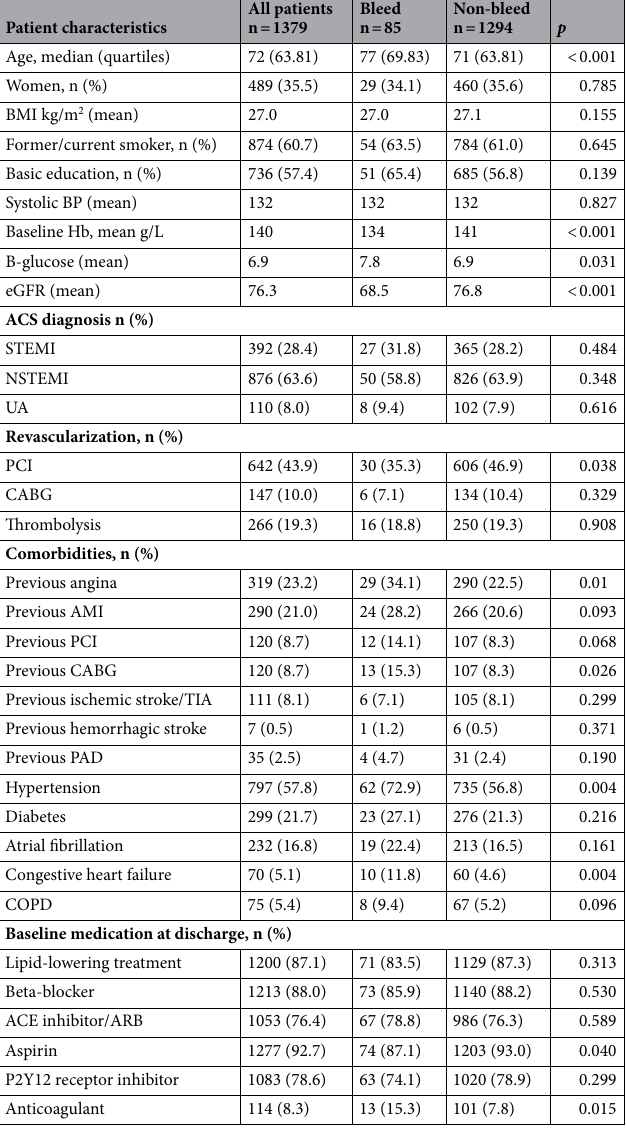
Table 1. Baseline characteristics stratified by bleeding. n number of patients, BMI body mass index, systolic BP blood pressure at discharge, eGFR estimated glomerular filtration rate calculated using mL/min/1.73 m 2 , ACS acute coronary syndrome, STEMI ST-elevation myocardial infarction, NSTEMI non-ST-elevation myocardial infarction, UA unstable angina, PCI percutaneous coronary intervention, CABG coronary artery bypass graft, TIA transient ischemic attack, PAD peripheral artery disease, ACE angiotensin-converting enzyme, ARB angiotensin receptor